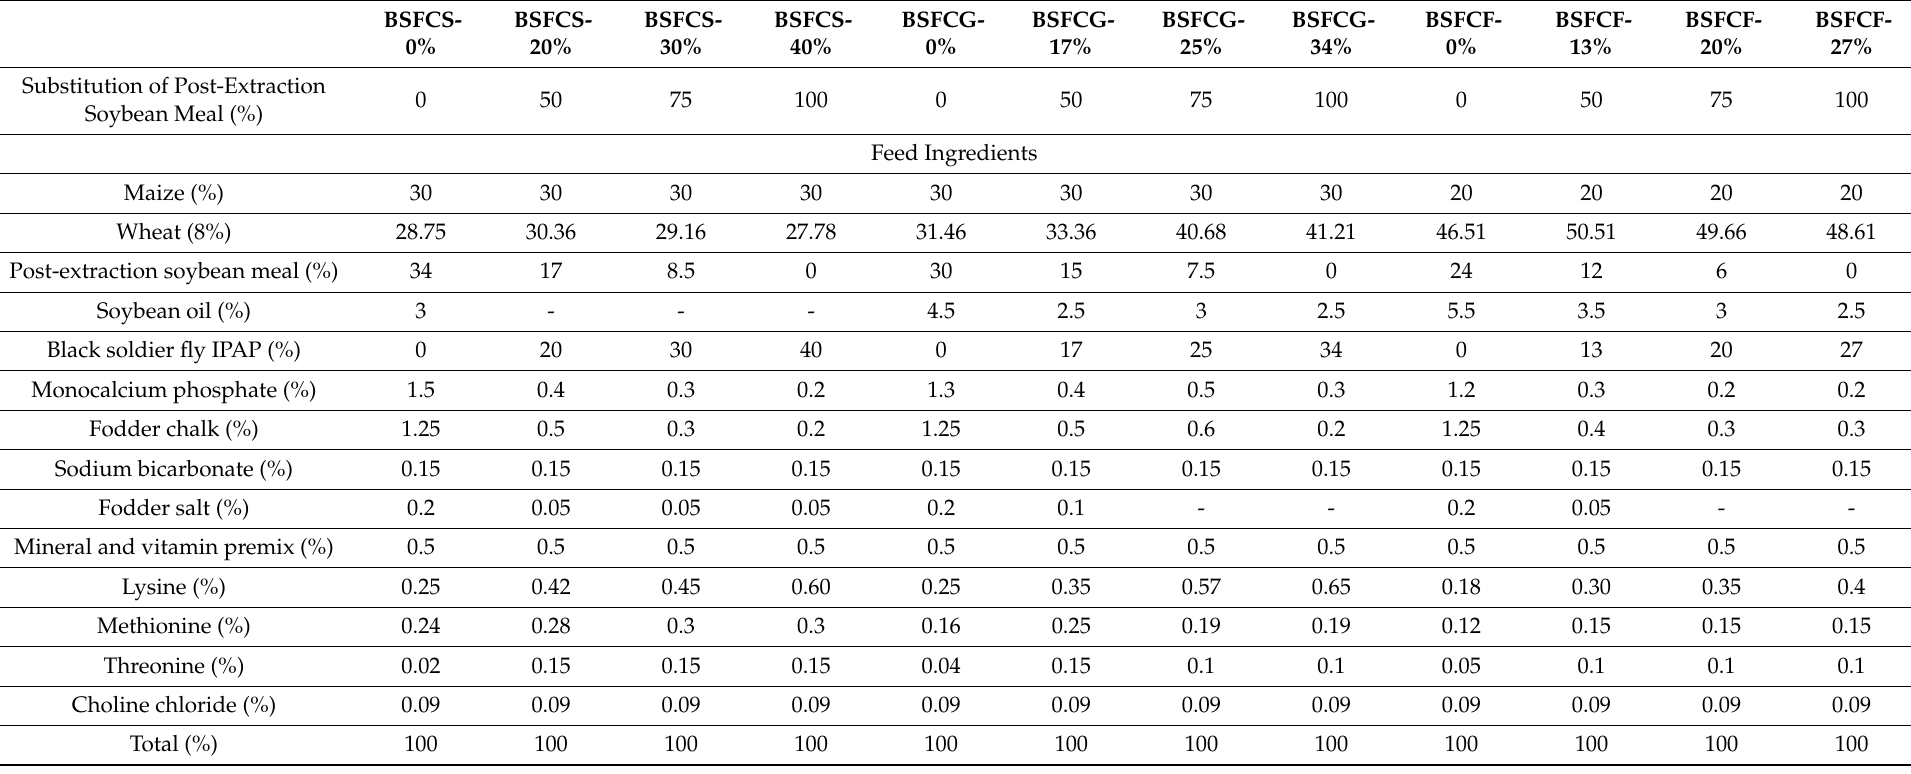
Table 4. Recipes of feed compounds with and without the addition of black soldier fly